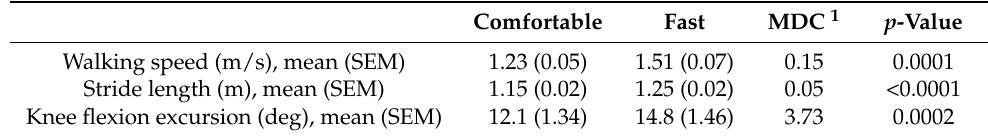
Table 3. Comparison results in walking speed, stride length and knee flexion excursion between speed conditions.